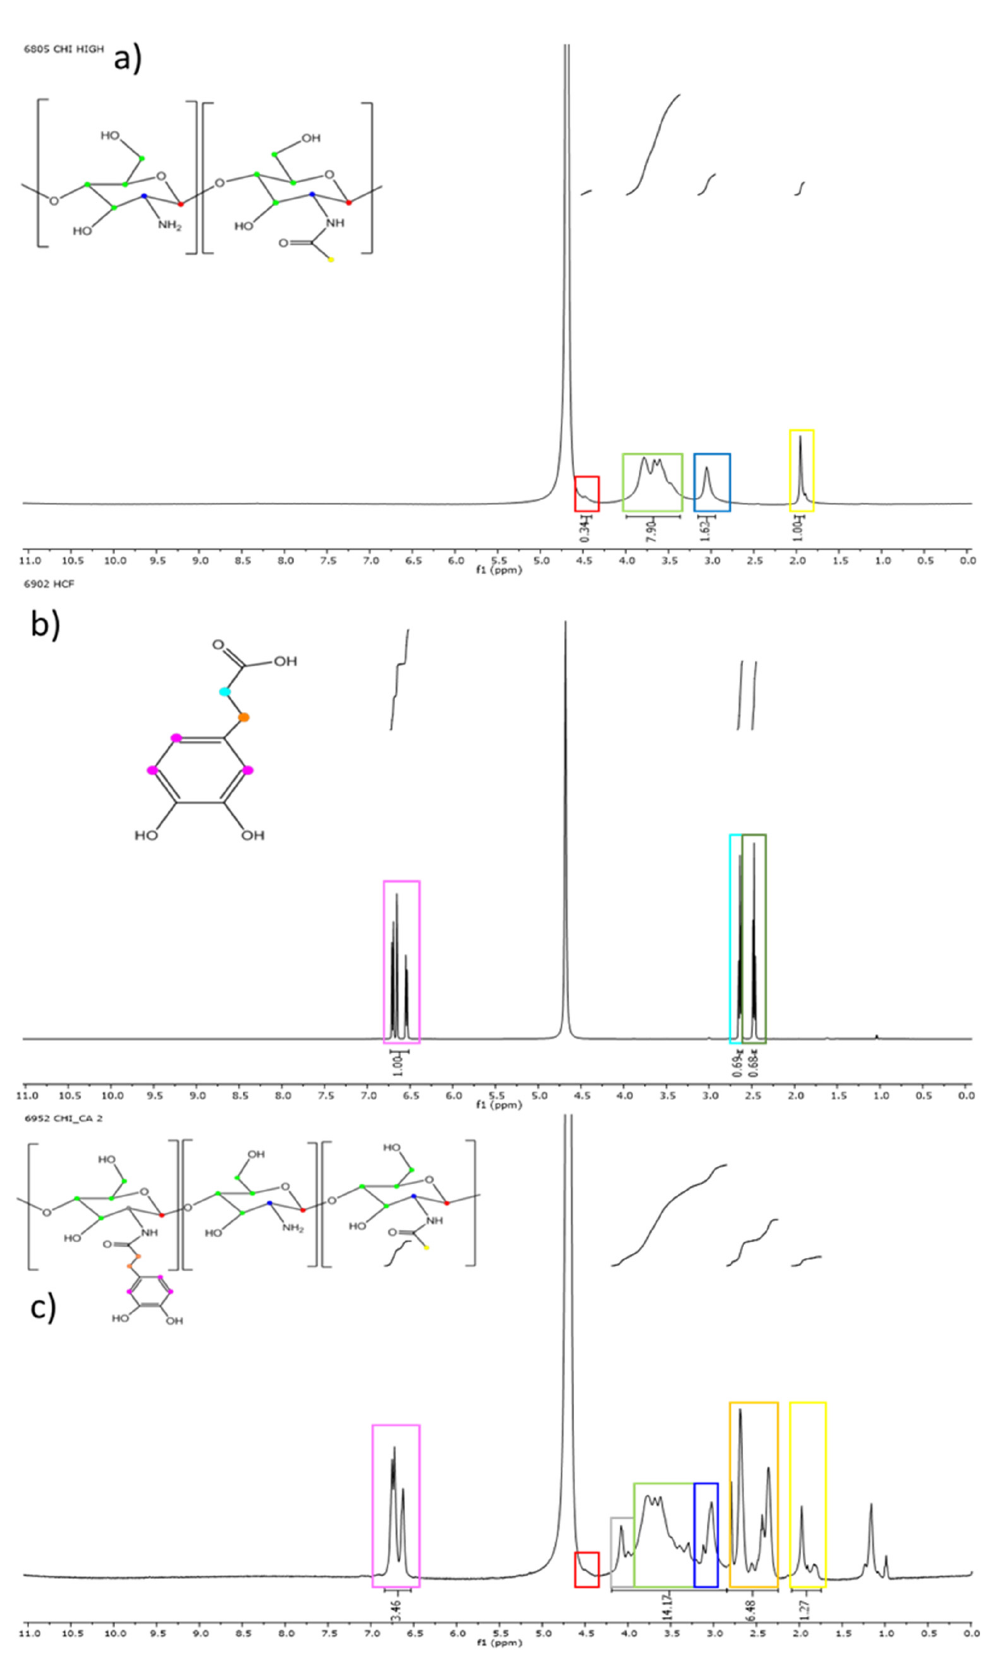
Figure 7. ( a ) High molecular weight chitosan spectrum. ( b ) Hydrocaffeic acid spectrum. ( c ) Chitosan modified with catechol (CHI-CA) spectrum.